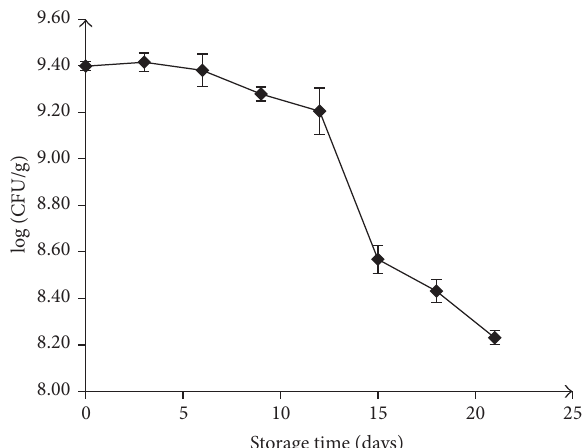
Figure 4: Effect of storage time at 4 ∘ C on the viable LGG of fermented Bsissa.